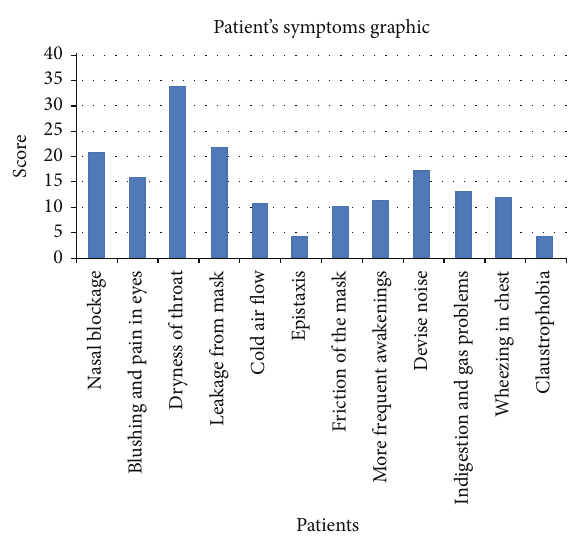
Figure 1: Graphic of patient’s complaints.